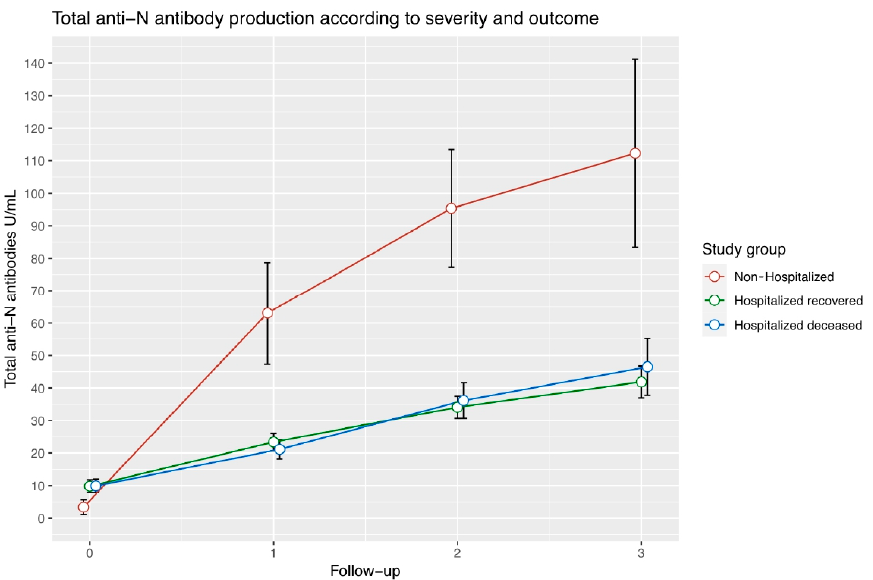
Figure 2. Longitudinal measurements of total anti-N antibodies in different groups of severity. Lineplot representing total anti-N antibody concentration through four longitudinal measurements. Each point represents the median neutralization value with standard error for that follow-up. The non-hospitalized patients group is represented by the orange line, the blue line represents recovered hospitalized patients, and the purple line represents deceased hospitalized patients.